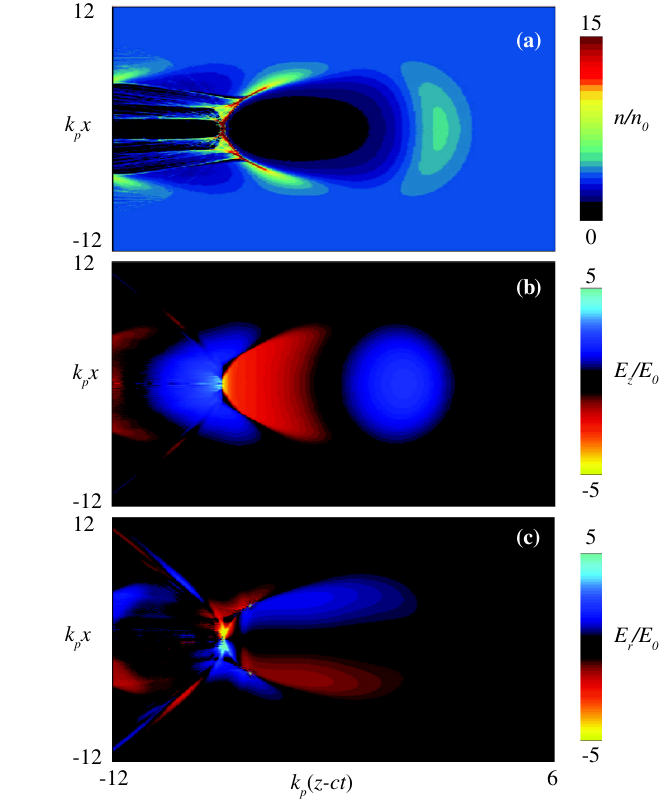
FIG. 2. Plasma wave excitation in the highly nonlinear cavi- tated regime: (a) electron density n=n , (b) axial electric field E z =E , 0 0 =E E , (c) transverse electric field E r =E . Profile of the normalized z 0 0 ized laser vector potential initially has the form a ¼ a ¼ 1 , k r ¼ 5 , and k L ¼ p L p 0 1 . Laser is propagating to the right [centered at k p ð z (cid:1) ct Þ ¼ 0 ] in initially uniform plasma. Positron acceleration and focusing only possible in electron density spike at the back of the cavity ð z (cid:1) ct Þ (cid:8) (cid:1) 7 : 5 k p